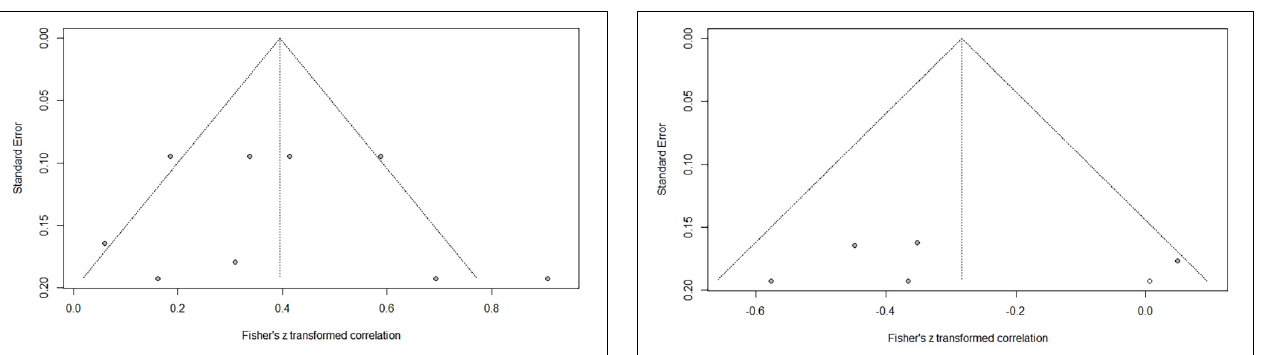
PA and Chinese word reading was observed ( Q B = 5.20,